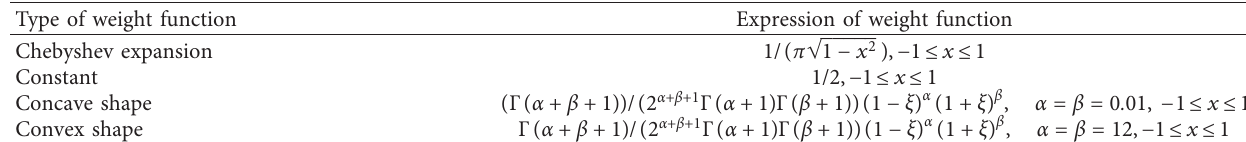
Figure 1: Three different types of weight Table 1: Expression of different weight functions.